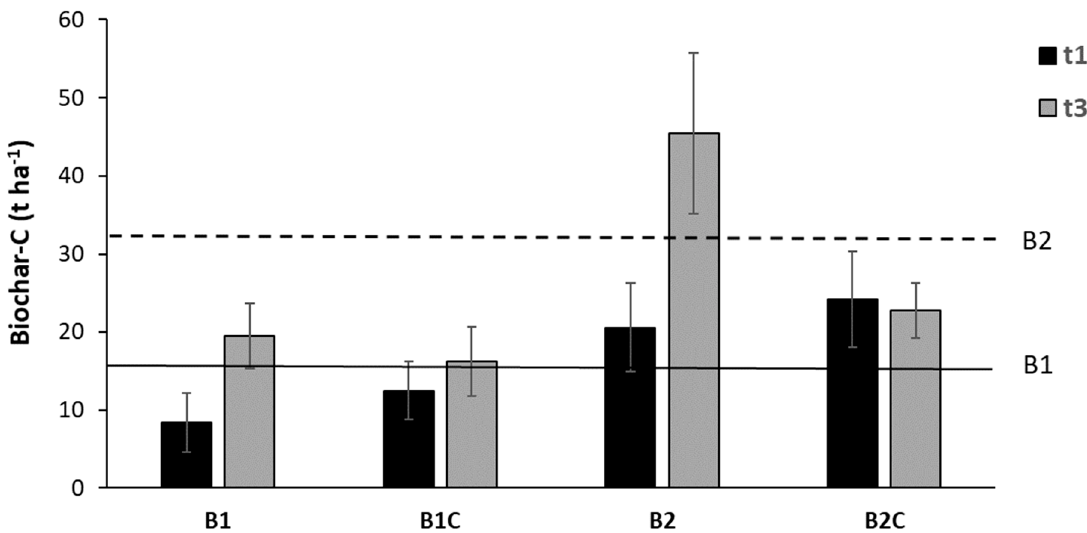
Figure 3. Biochar-C content in soil (t ha − 1 ) according to BPCA analysis in the experimental treatments B1 (25 t ha − 1 biochar), B2 (50 t ha − 1 biochar), B1C (25 t ha − 1 biochar + 45 t ha − 1 compost), and B2C (50 t ha − 1 biochar + 45 t ha − 1 compost) 3 weeks after the application of soil amendments (black bars in the graph, t1) and 2 years later (gray bars, t3). The amount of biochar-C naturally present in the soil before the distribution of amendments (t0) was subtracted from the quantity measured in the soil samples at t1 and t3. The horizontal lines represent the doses of biochar-C applied (B1, continuous line and B2, dashed line). No significant differences were found between the time t1 and t3 ( p ≤ 0.05). Vertical bars represent the standard error of the mean.